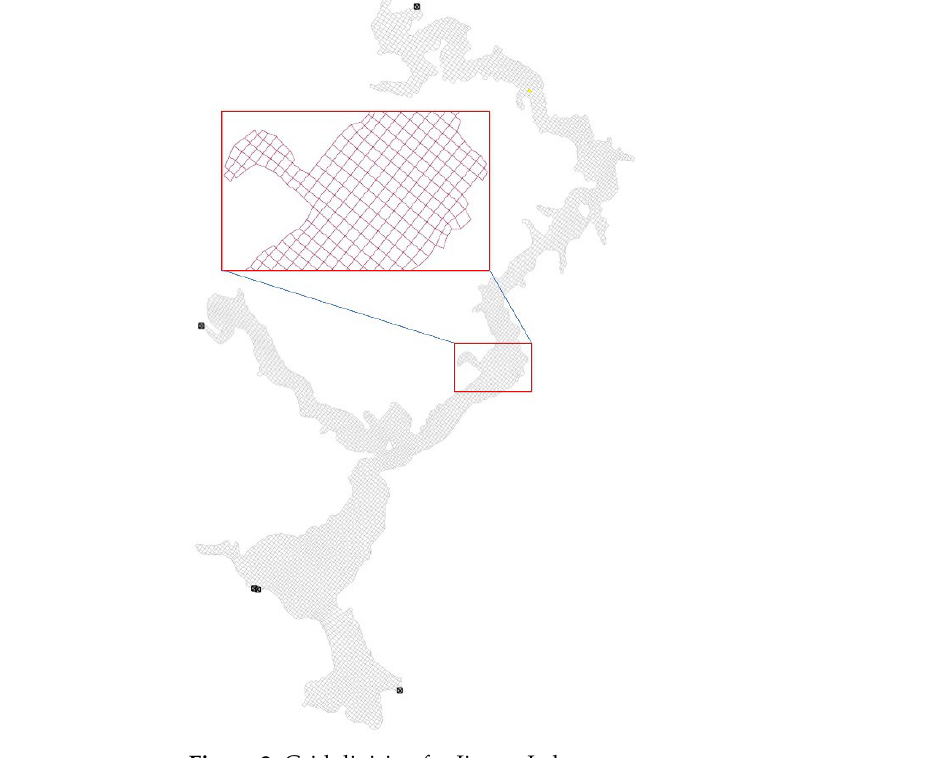
Figure 2. Grid division for Jingpo Lake.